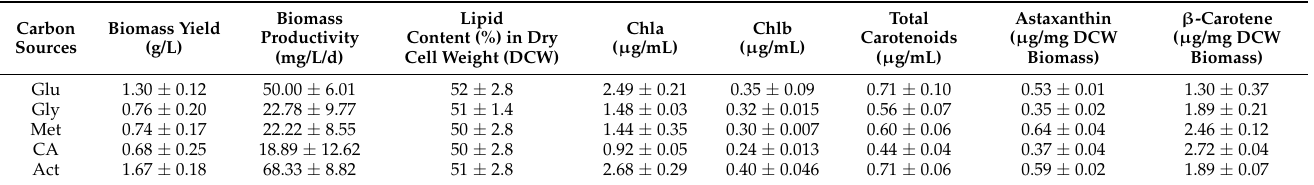
Figure 4. Influence of different organic carbon sources in the growth of Picochlorum sp. BDUG-100241; glucose (Glu), glycerol (Gly), methanol (Met), citric acid (CA) and sodium acetate (Act). Table 1. Biomass and biomolecule production in different carbon sources ( n = 3), ± (standard deviation of replicate